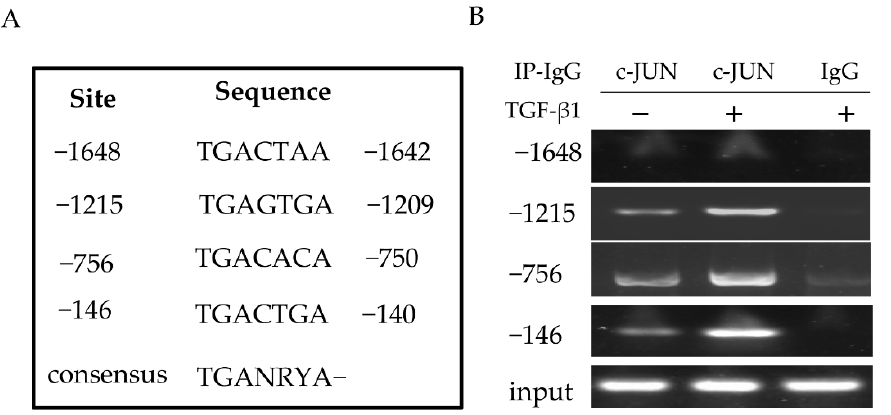
Figure 4. Evaluation of c-JUN binding to porcine pFcRn promoter in vivo. ( A ) The putative c-JUN binding sites in the pFcRn gene are indicated. Numbers show the putative c-JUN binding